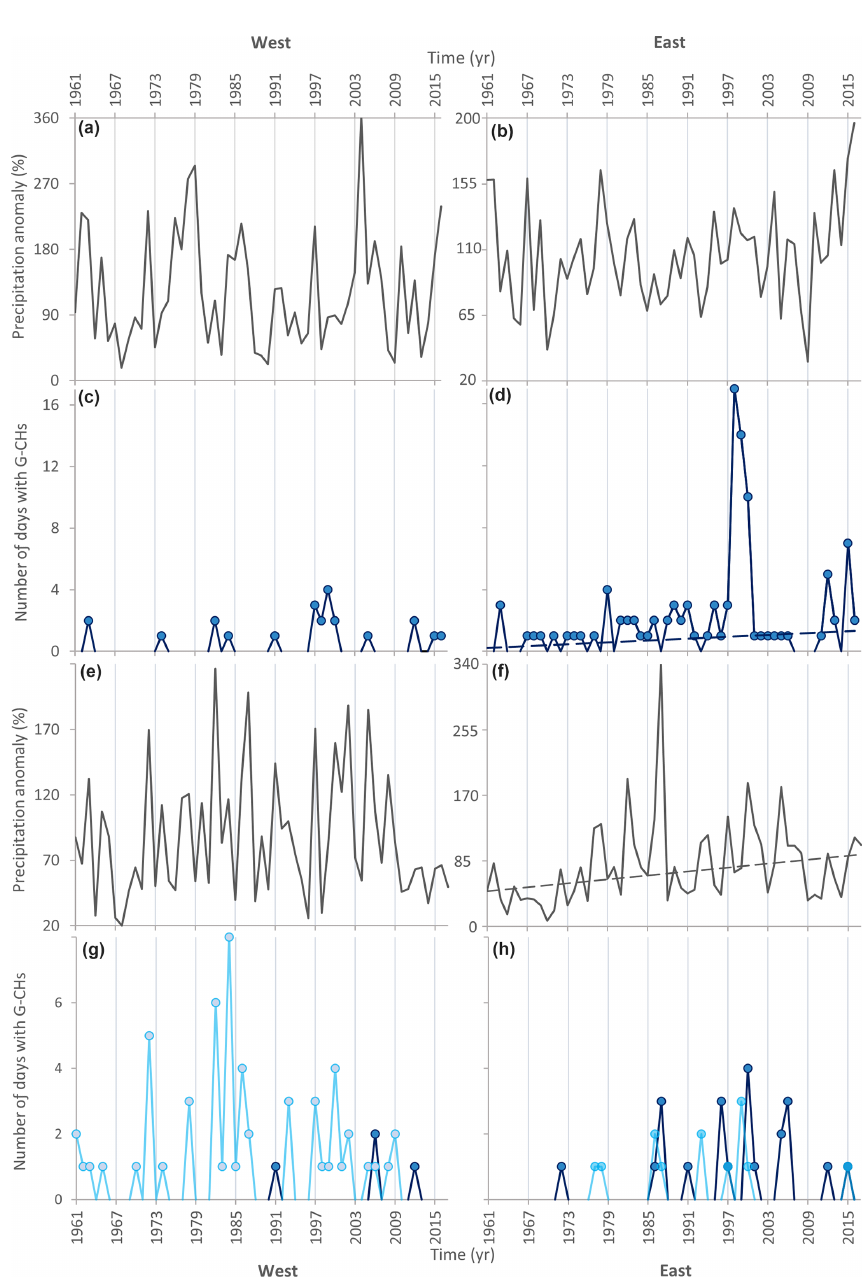
Figure 7. Trends in drivers and G-CHs. Series of precipitation (grey lines) and number of days with G-CHs (lines with points) in the W zone (a, c, e, g) and E zone (b, d, f, h) for (a–d) summer and (e–h) winter months. In the case of G-CHs, blue refers to rainfall-driven hazards and light blue to snowfall-driven hazards. Dashed lines indicate significant trends at 95%